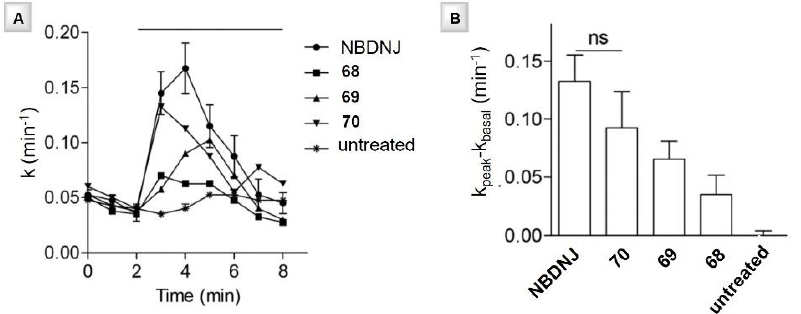
Figure 14. ( A ) Rescue of functional F508del-CFTR activity. Iodide e ffl ux curves on untreated or iminosugar-treated F508del-CFTR stably transfected HeLa cells in the presence of forskolin / genistein. ( B ) Summary of the functional evaluation of F508del-CFTR. Histograms represent the mean ( ± SEM) of four experiments obtained by the iodide e ffl ux technique in CF cells untreated or treated with the iminosugar (100 µ M, 4 h). ns, not significant. This figure is adapted from [146], published by the Royal Society of